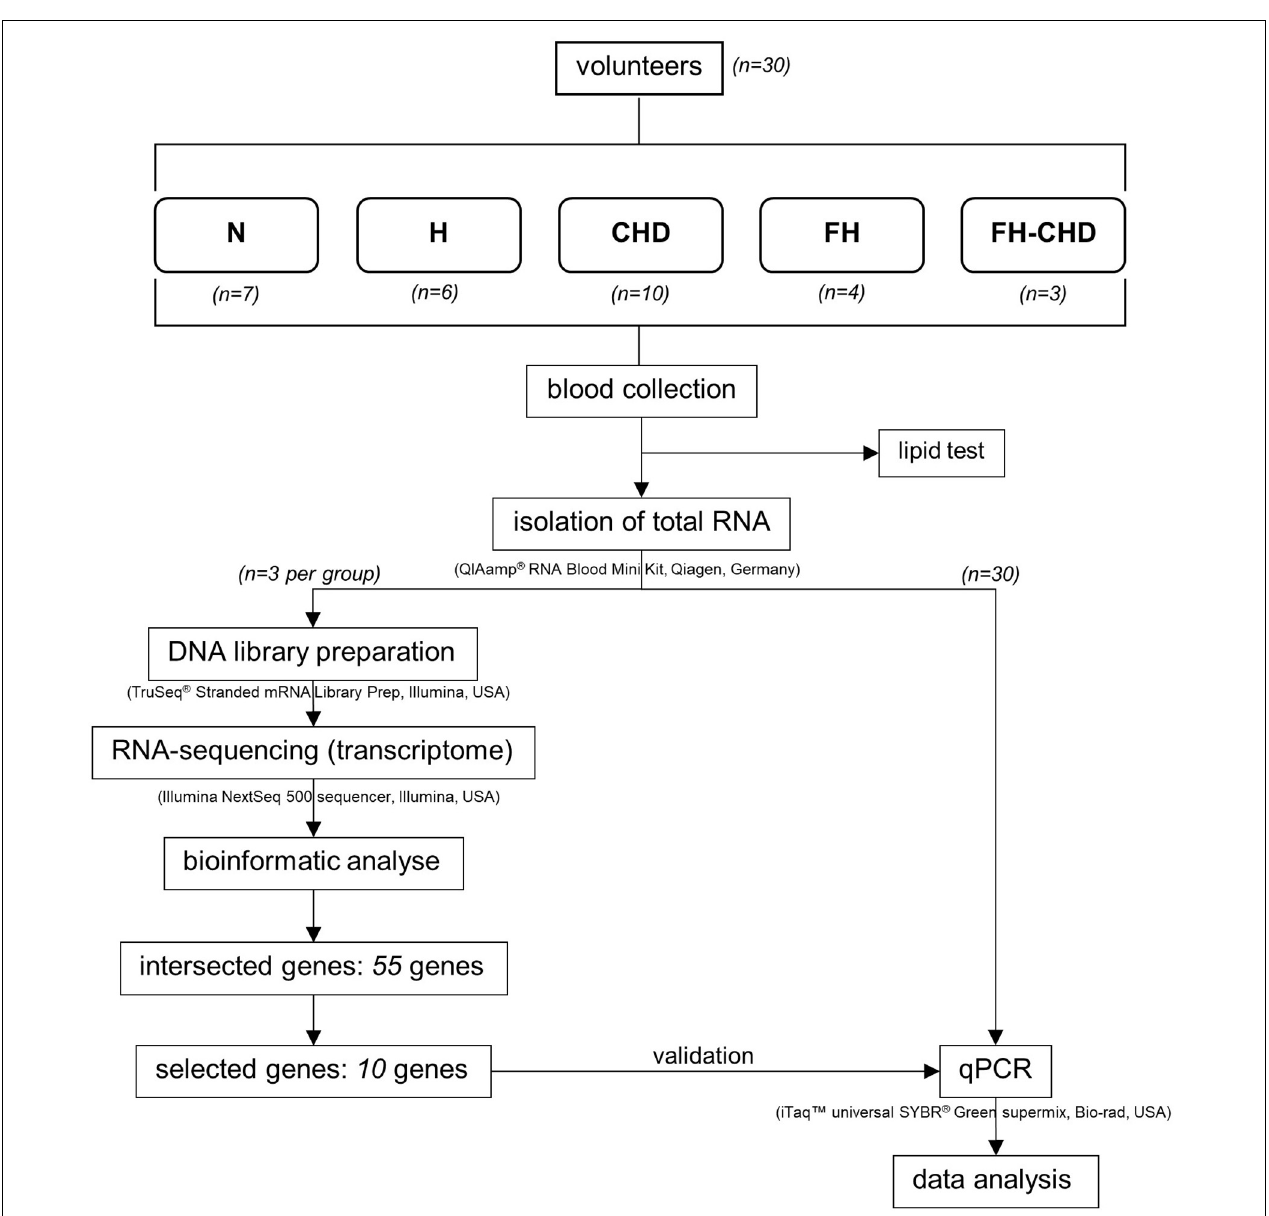
FIGURE 1 | Experimental design and study